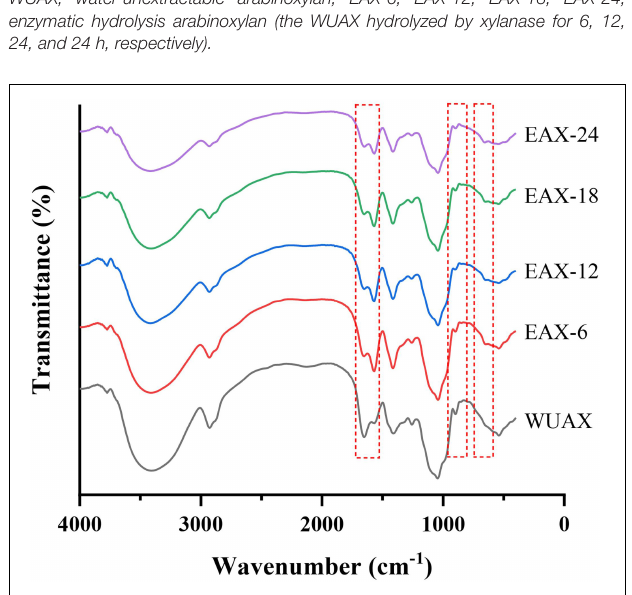
FIGURE 1 | The FTIR spectrum of WUAX and EAX. WUAX, Water-unextractable arabinoxylan; EAX6, EAX12, EAX18, EAX24, enzymatic hydrolysis arabinoxylan (the WUAX hydrolyzed by xylanase for 6, 12, 24, and 24 h,